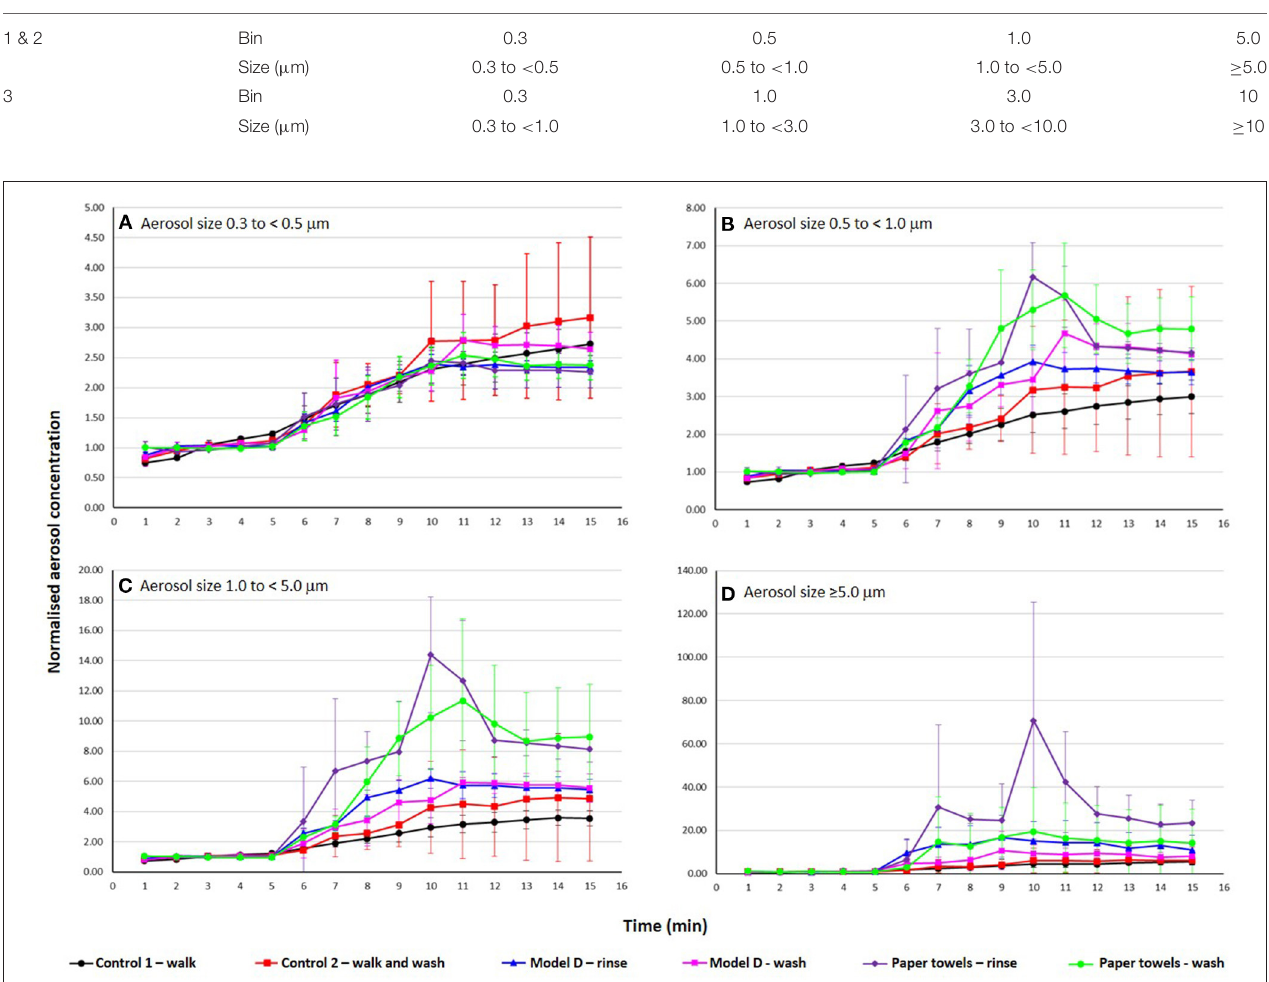
TABLE 3 | Aerosols size range for each bin for each location. Location